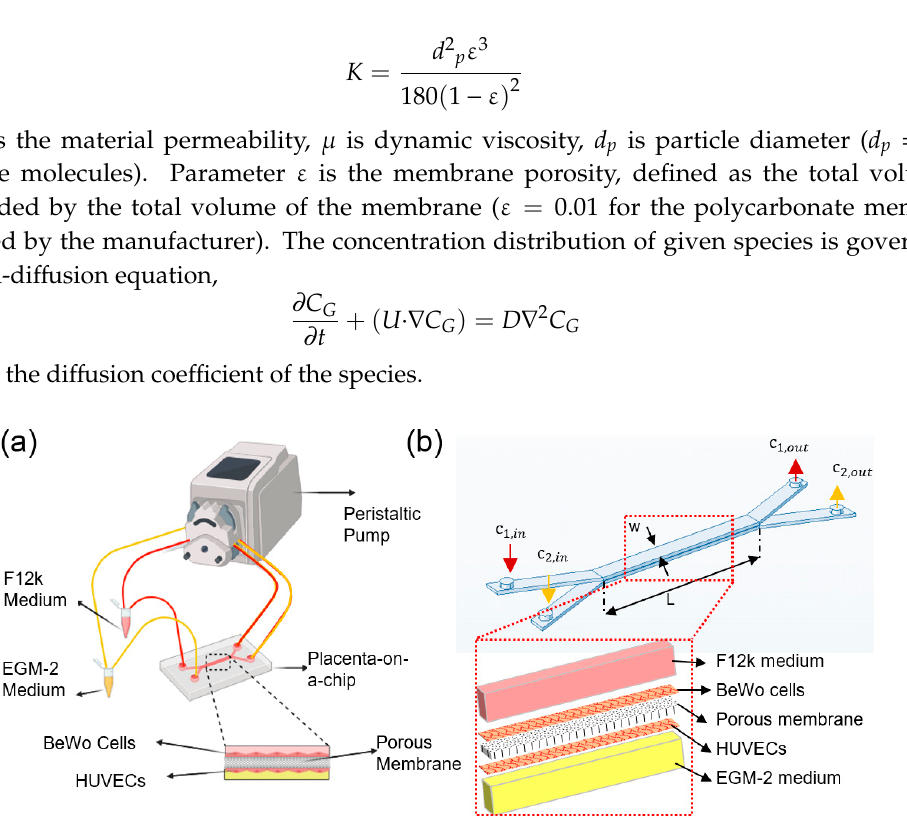
Figure 1. Glucose transfer analysis in the microfluidics-based modeling of human placental barrier: ( a ) schematic of the experimental setup, ( b ) geometry of the placenta-on-a-chip device with inset showing the exploding view of the multiple layers for finite element simulation.